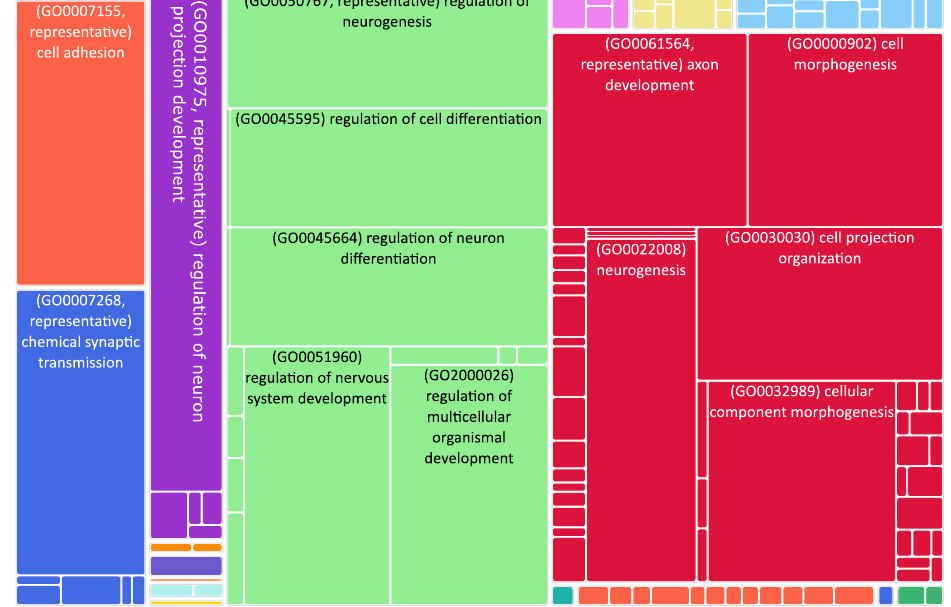
Figure 2. Tree map of downregulated genes in the stage 4 + 4S. Each rectangle is a single cluster representative. The representatives are joined into “superclusters” of loosely related terms, visual- ized with different colors. Sizes of the rectangles are adjusted to reflect the p -value of the GO term (“biological process”). Most representative terms are indicated. Several terms associated with neu- ronal function are enriched.